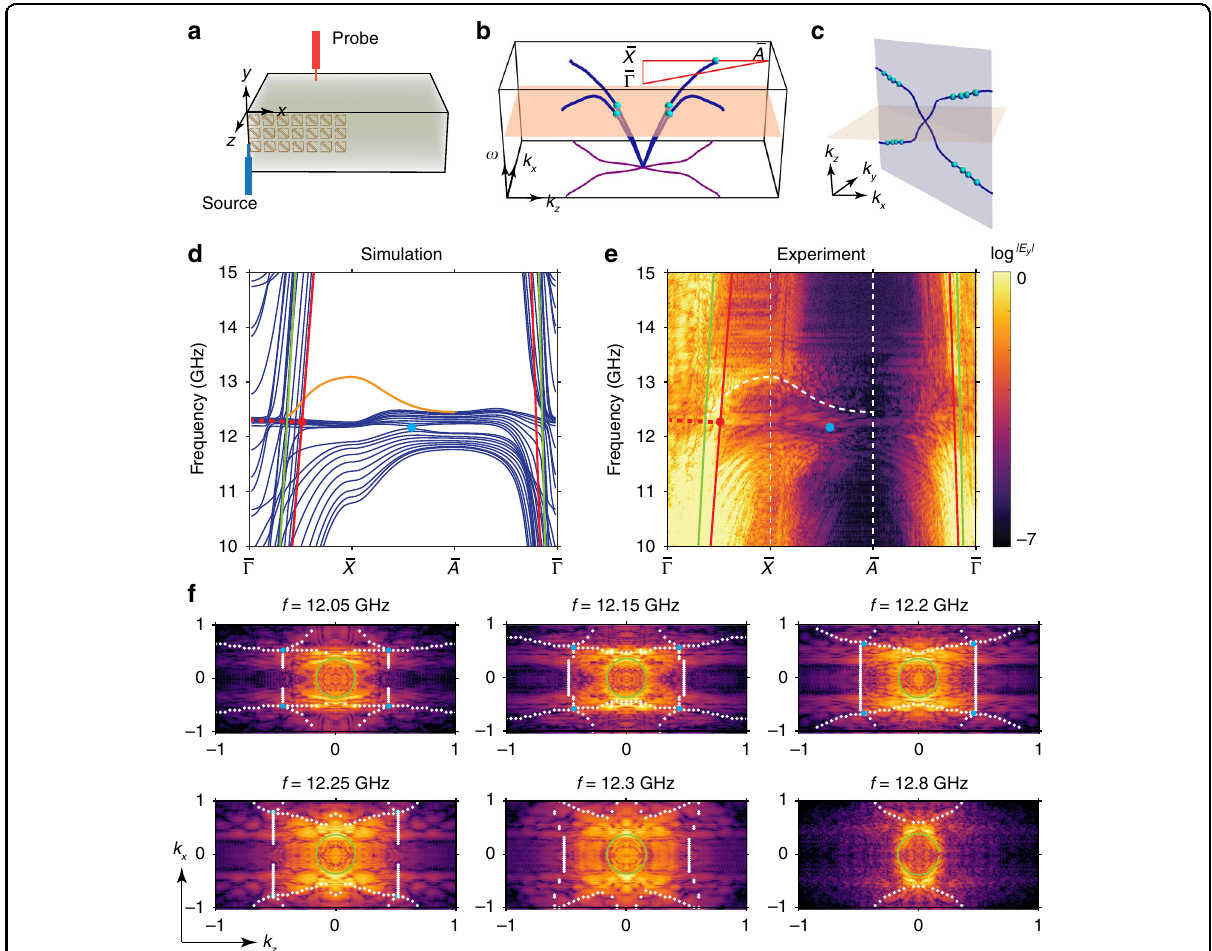
Fig. 4 Experimental mapping of in-plane nodal chain within bi-anisotropic metamaterials. a Schematic of bi-anisotropic metamaterials for side surface (xz plane) scanning. Source and probe antennas are indicated in blue and red, respectively. b Calculated in-plane nodal chain (blue curves) dispersion, and its projection onto the k x − k z plane as the in-plane nodal chain (purple curves). Cyan dots show the degenerate points on one particular equi-frequency plane. Red triangle shows the path for the band spectra shown in d , e . c In-plane nodal chain in momentum space, blue lines are calculated results and cyan dots are from measurement results of f . d , e Calculated and experimentally mapped band spectra along Γ - X - A - Γ . For both simulation and experimental results, the blue dot marks the point where the nodal chain meets the Brillouin zone boundary on the X - A line. Surface mode is indicated with orange curve in d and white dashed curve in e . Nodal ring projection is indicated with red dashed line. Light cone for air and effective substrate ( ε b ≈ 1.95) are shown with green and red solid lines, respectively. f Experimentally mapped EFCs for different frequencies. Calculated EFCs are marked with white dots. Blue dots indicate the nodal points at the corresponding frequencies. Green rings are the EFCs of light cone for